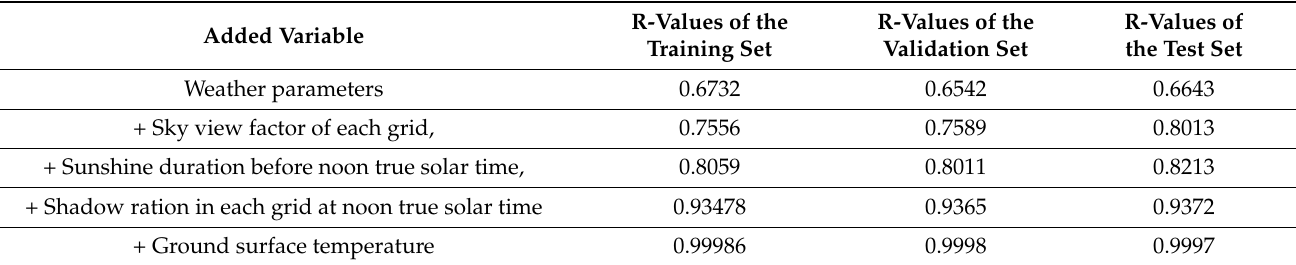
Table 4. A summary of R-values of the subset of the training dataset and validation dataset after adding additional variables.